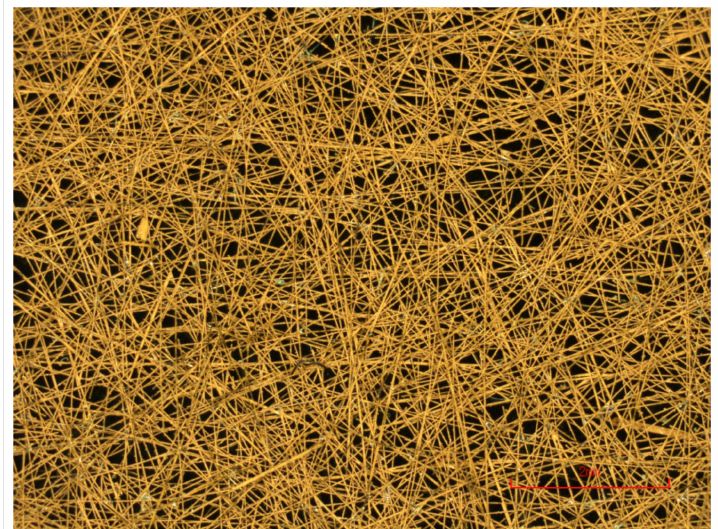
Figure 2. Close-up view of copper-coated carbon